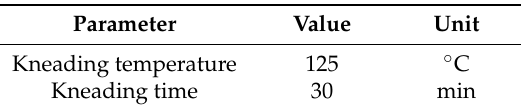
Table 1. General kneading settings.